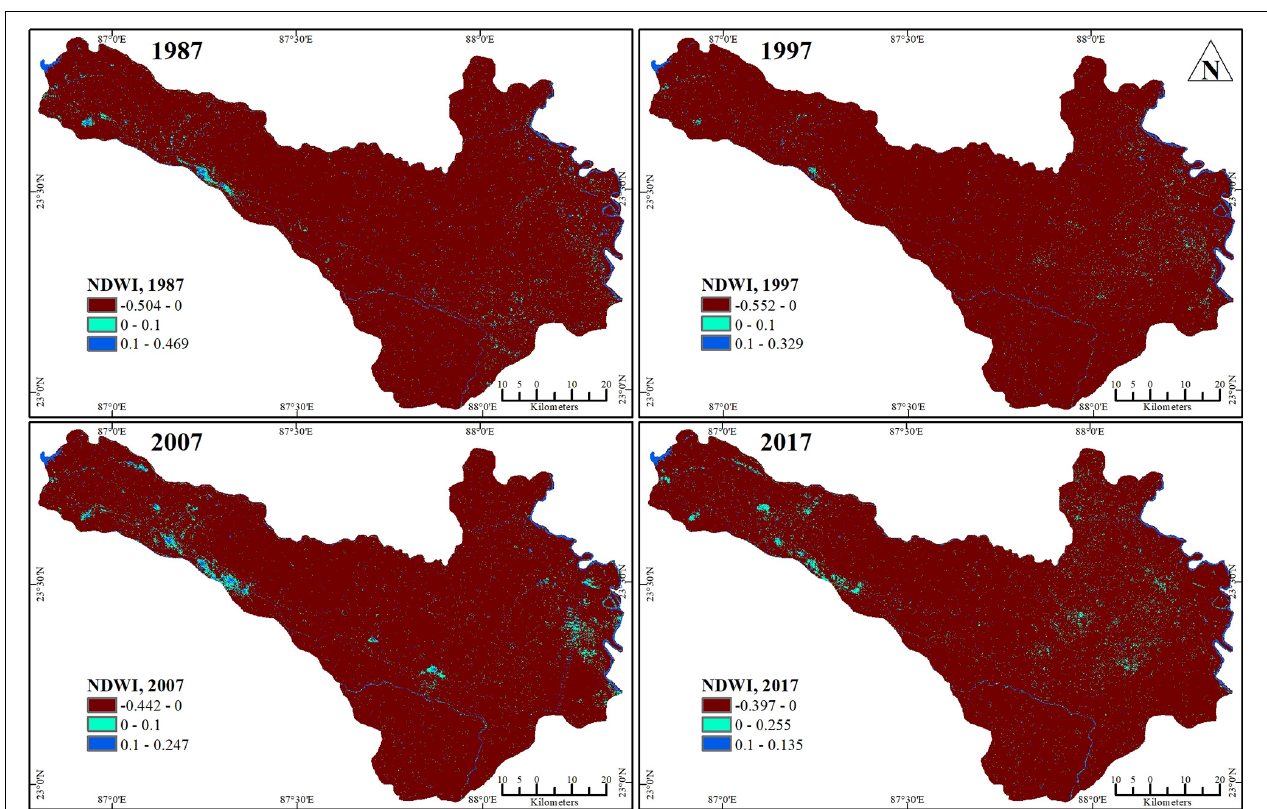
FIGURE 6 | Normalized Difference Water Index (NDWI). Author, 2019. (Landsat 5 and 8 satellite imagery, USGS).